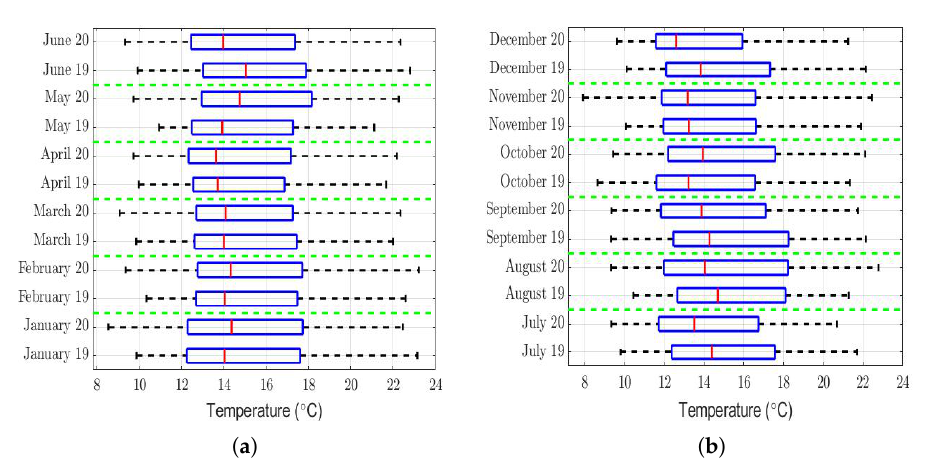
Figure 9. Box plot of the temperature ( ◦ C): 2019 vs. 2020. ( a ) First semester. ( b ) Second